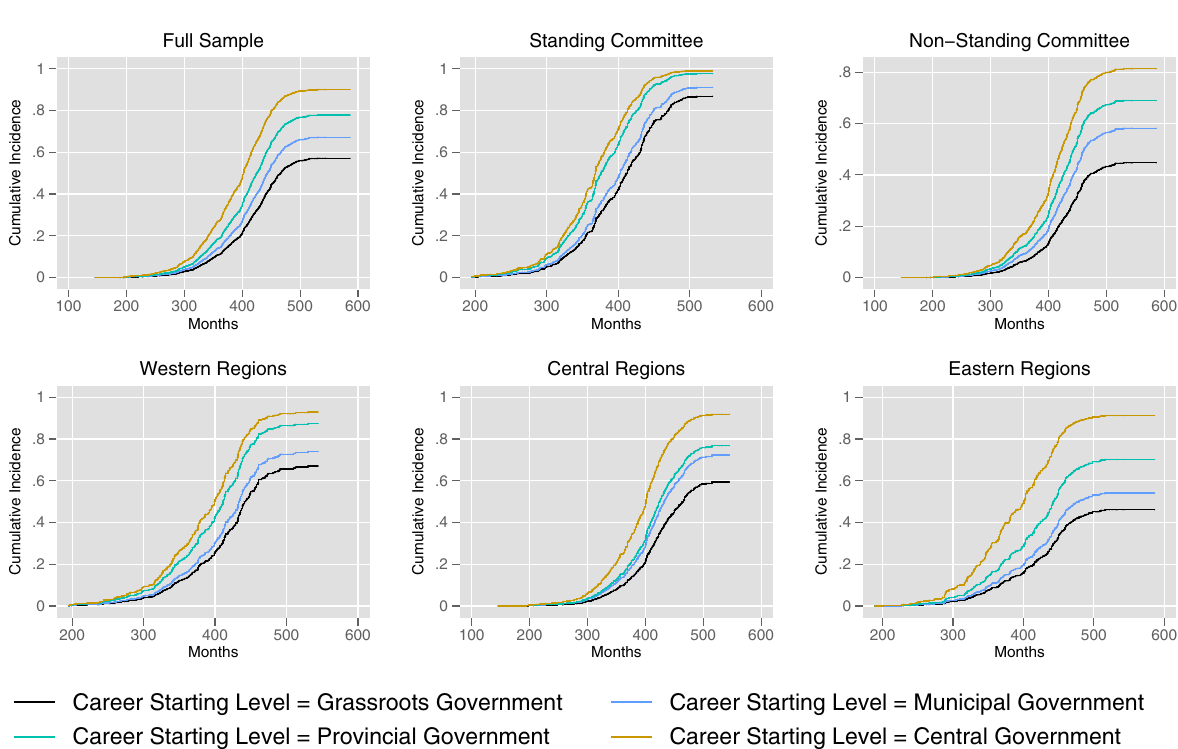
Fig. 2 The cumulative incidence curves of risk of political promotion. The cumulative incidence curves of political promotion from the highest to the lowest are central government beginnings, provincial government beginnings, municipal government beginnings and grassroots government beginnings, which indicates that deputy mayors with higher career starting levels have higher cumulative rate of political promotion. Thus, deputy mayors who started in the grassroots-level governments always had the lowest cumulative political promotion